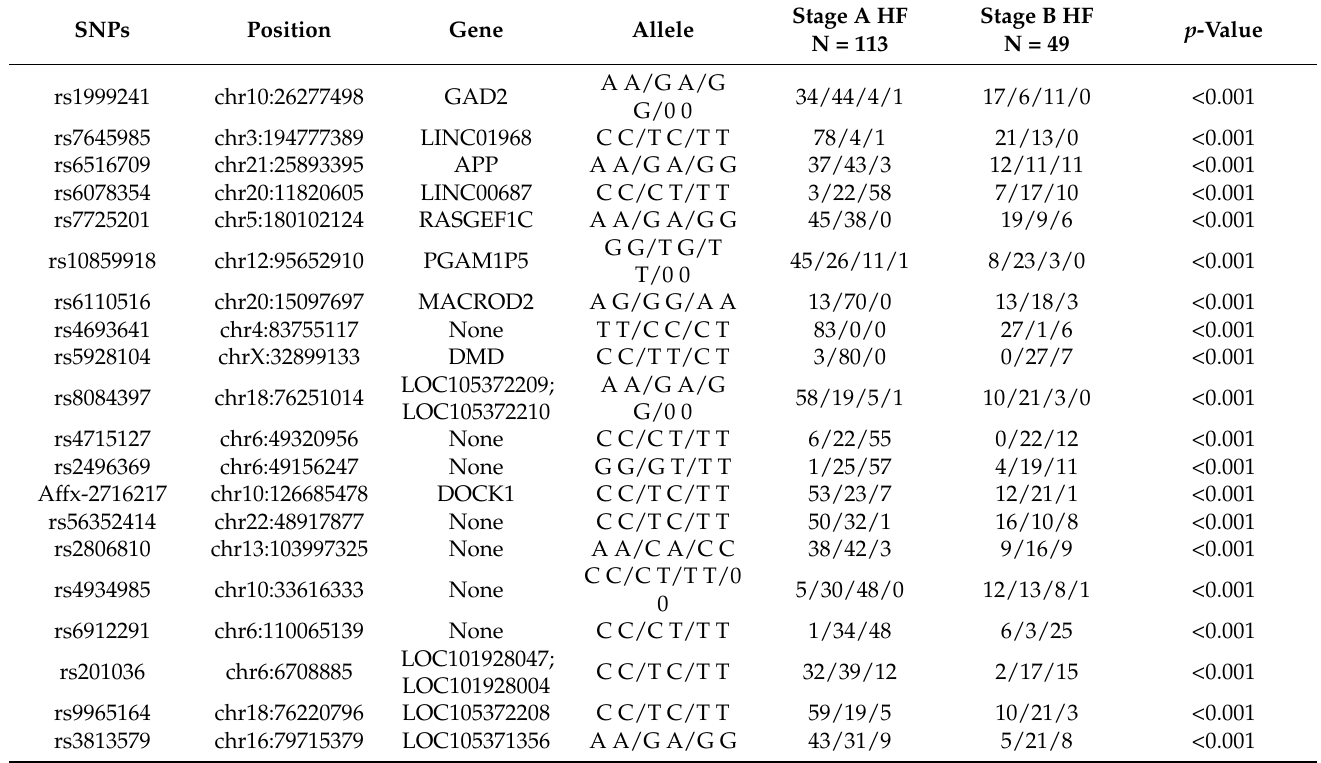
Table 4. Top 20 SNPs of both